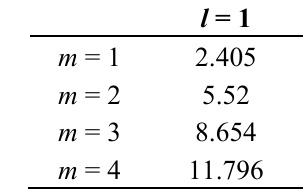
for some of the lowest-order 1m